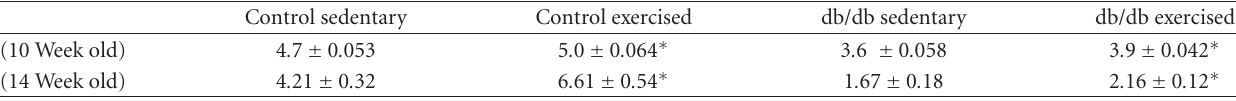
Table 2: Citrate synthase activity (umole/mL/min) in thigh adductor muscle of all experimental groups.